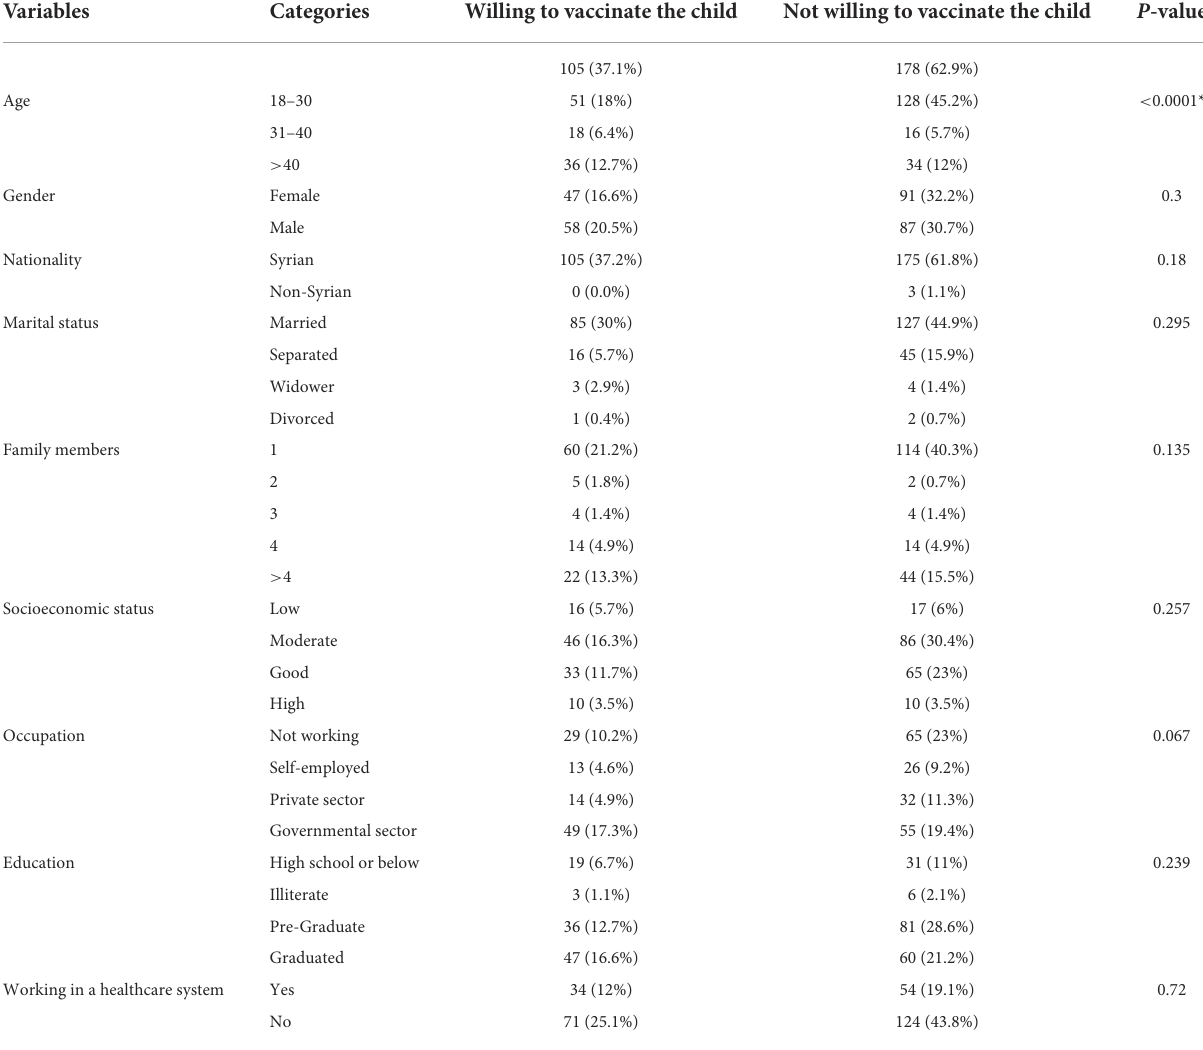
TABLE 2 Parental characteristics associated with the willingness to vaccinate their children with a COVID-19 vaccine. Variables